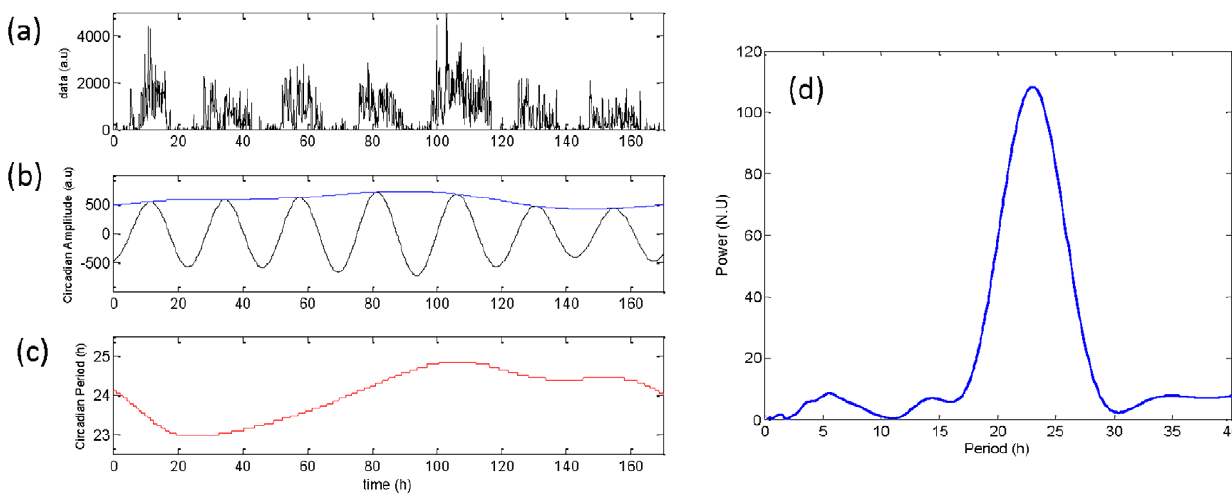
Figure 5. Estimated predominant component of motility data. (a) The raw data in arbitrary units (a.u). (b) The estimated circadian rhythm (black line) with its amplitude (blue line). (c) The estimated circadian period (red line) in hours. Due to the non-stationary nature of the data, the estimated amplitude and the period show cycle-to-cycle variability. (d) Normalized scalogram at a specific time of 32 hr. The peak power occurred at a period of 23 h